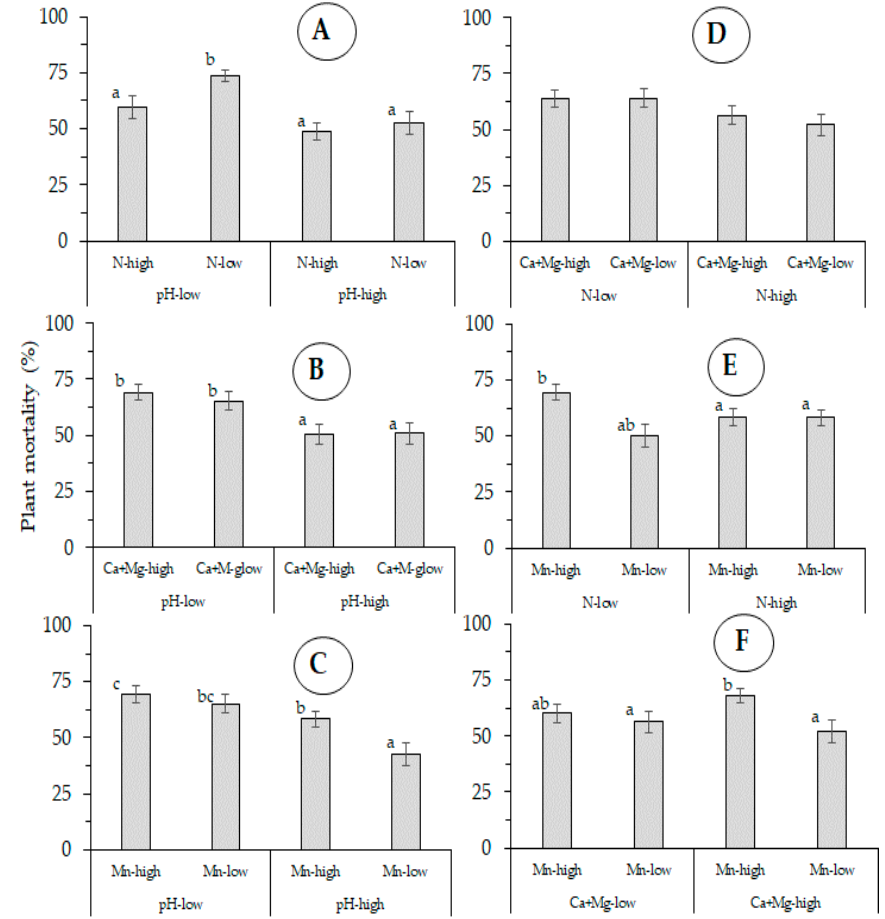
Figure 5. Aerial perspective from 30 m altitude of the impact of soil pH on plant mortality by Fusarium wilt (Foc race 1) of Gros Michel banana in the Exp-east in 28 Millas (Costa Rica) between the 2nd and 3rd crop cycles (aerial photo: Jean-François Michaud, CBC, Radio-Canada) .